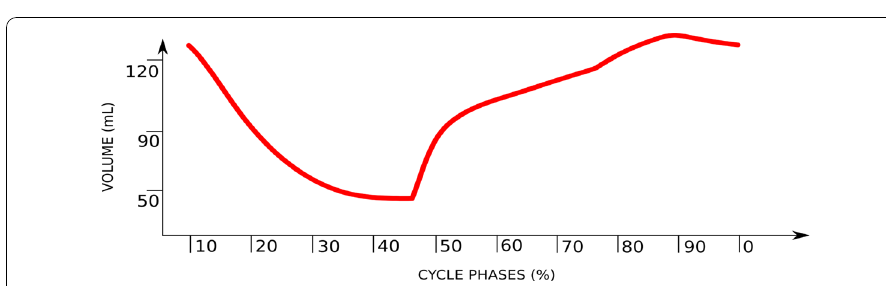
Fig. 18 Three scanned ventricle geometries by corresponding phases